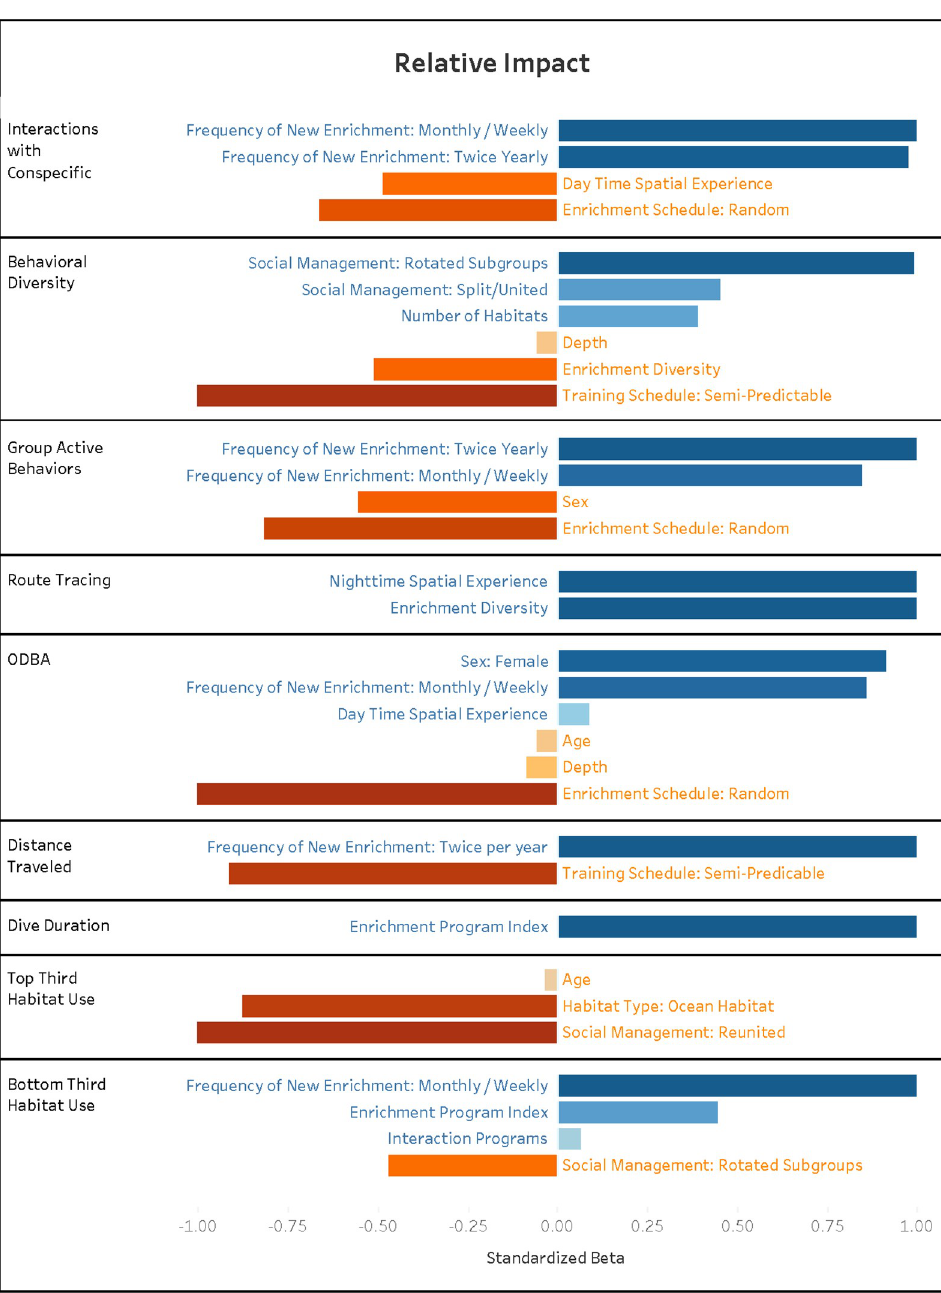
Fig 2. Relative impact outcome and independent variable associations for all significant variables within the collection. Beta values were standardized by dividing the Beta value by the maximum Beta value of each individual model. Directional effects are represented as positive and negative associations with the dependent variable. Positive associations indicate an increase in the dependent variable and negative associations indicate a decrease in the dependent